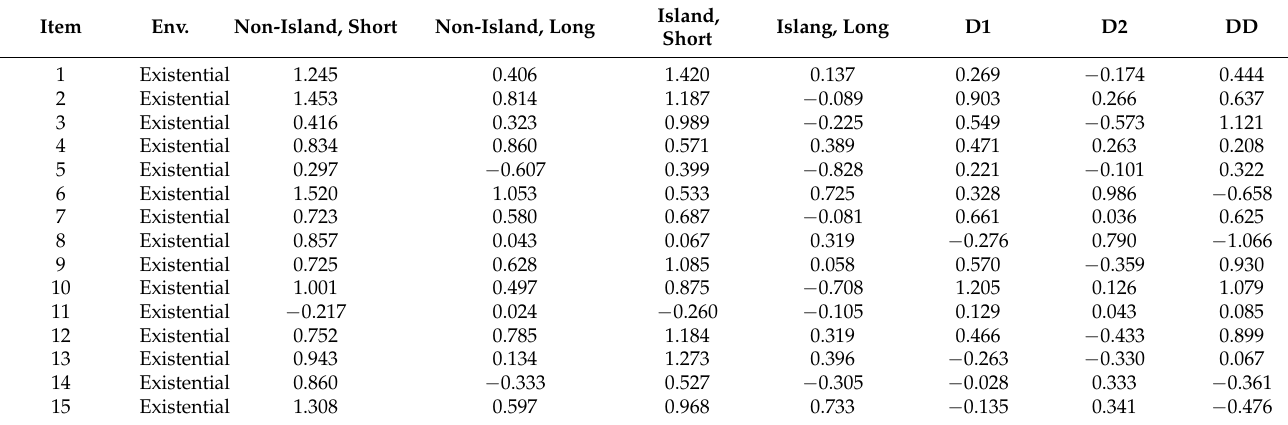
Table A8. DD score calculation table for Experiment 1, Existential conditions. The table displays the z-scored ratings for each condition and the intermediate differences used to calculate the DD score by item. Refer to Section 2 for a description of the procedure for calculating DD scores. The DD scores below are averaged for the Existential environment and presented in Figures 2 and